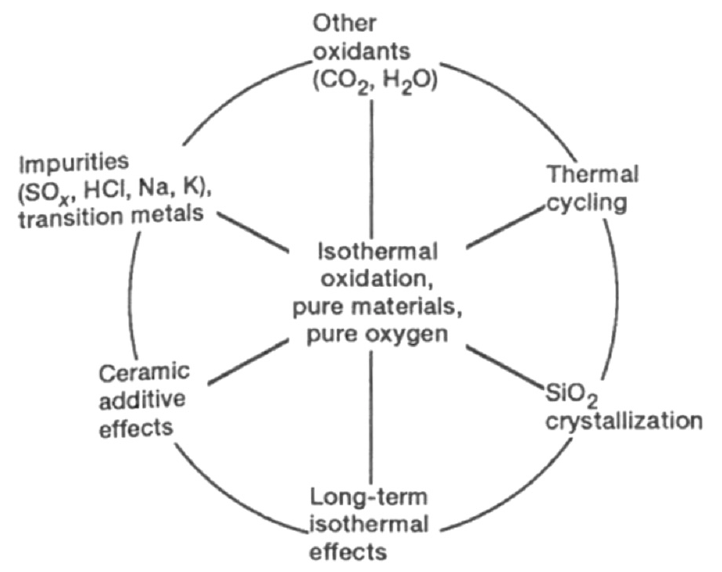
Figure 13. Complications to isothermal oxidation due to additive-containing ceramics and com- bustion environments. Reprinted with permission from Reference [7]. Copyright 1993 The Ameri- can Ceramic Society/Wiley.